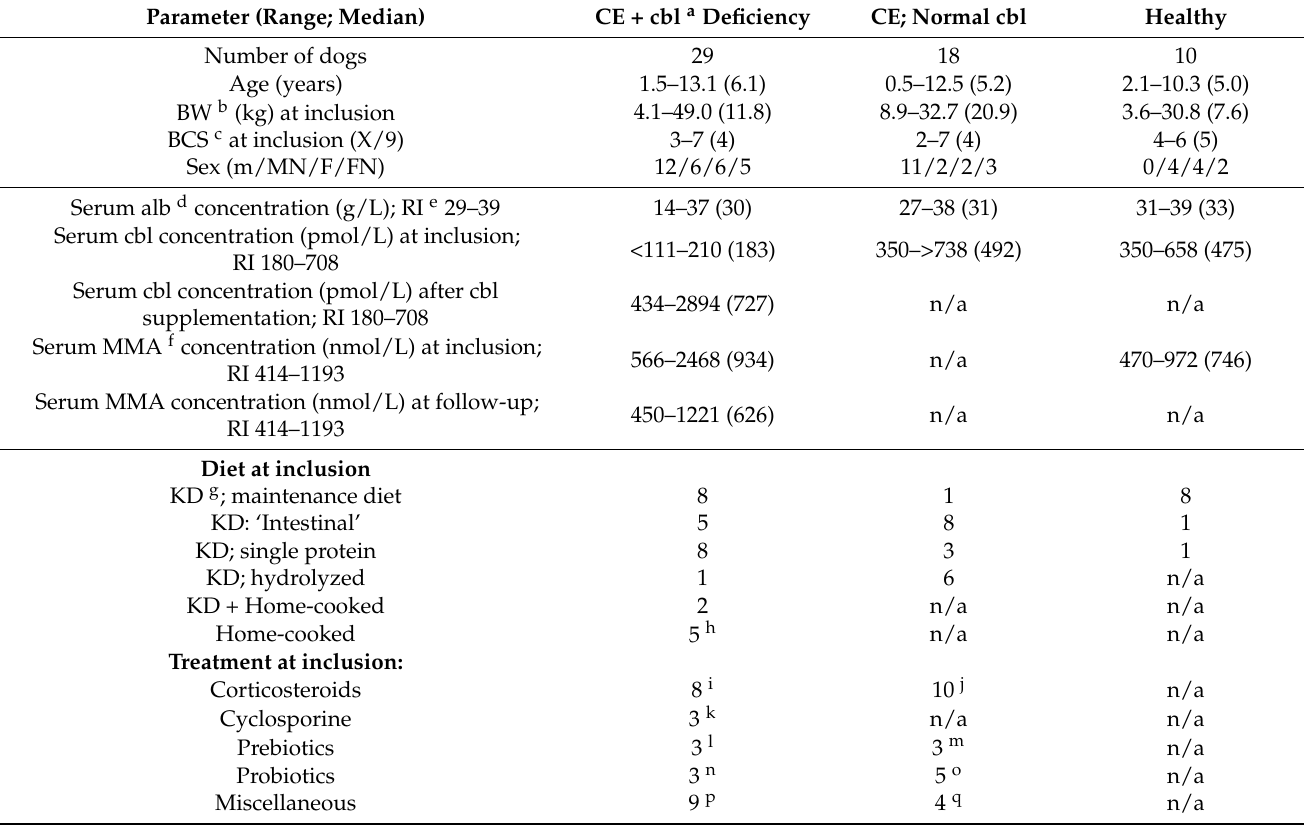
Table 1. Selected parameters data from 29 dogs with chronic enteropathy (CE) and cobalamin deficiency, 18 normocobalaminemic dogs with CE, and 10 healthy dogs. Numbers in parentheses indicate the